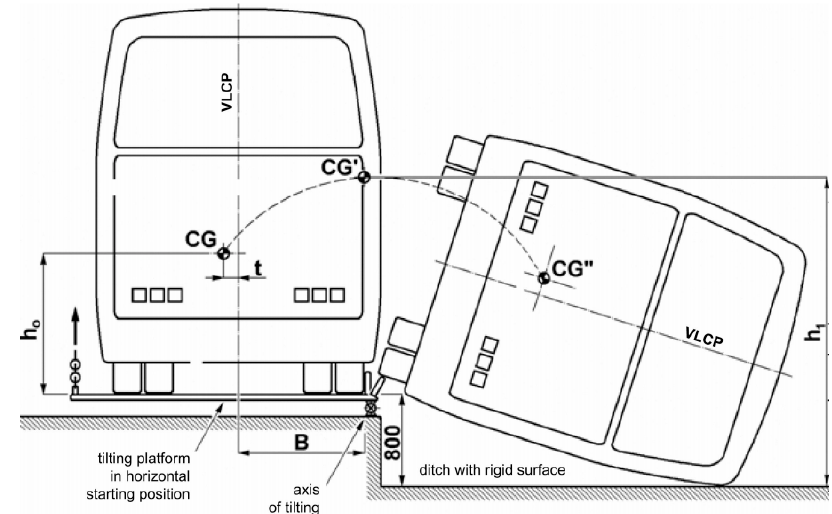
Figure 1. The computational model of a bus rollover [14].